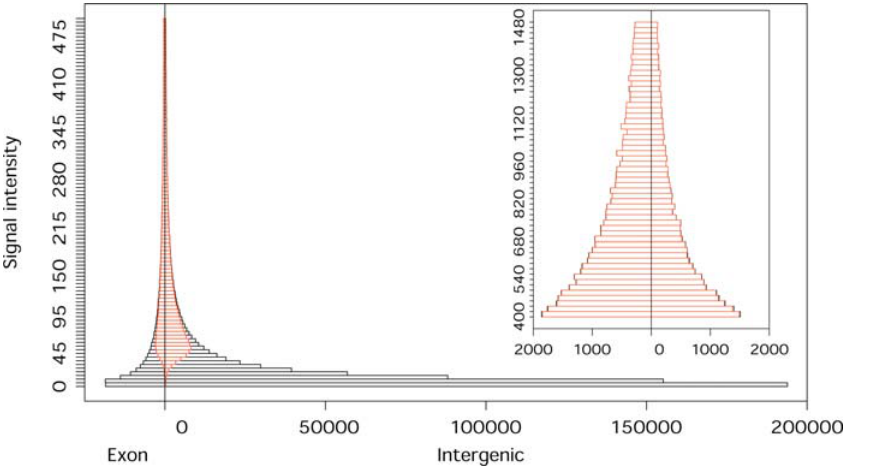
Figure 1. Signal Intensities of Exonic and Intergenic Probes The signal intensity range presented in the main figure covers 95% of all array probes with positive signal intensity. The insert shows the signal intensity range including the additional 4% of array probes. The x -axis shows the number of exonic and intergenic probes. Red indicates the proportion of probes we classified as expressed. Since there exists no empirically established cutoff for classifying tiling array probes into ‘‘ expressed ’’ and not expressed, we chose an arbitrary cut-off based on both absolute signal intensity and relative expression of perfect match and mismatch probes (Materials and Methods). The distribution presented here is based on an average of the four tissues. Taken separately, all tissues show very similar distributions (Figure S1). DOI: 10.1371/journal.pgen.0020171.g001